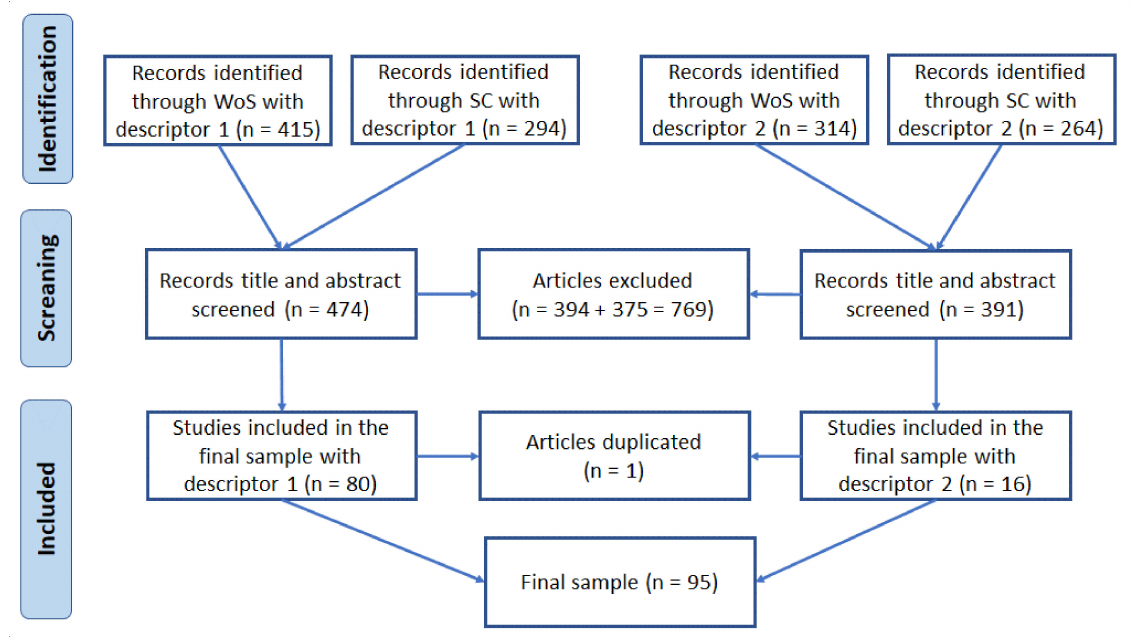
Figure 1. Flowchart of the sample’s